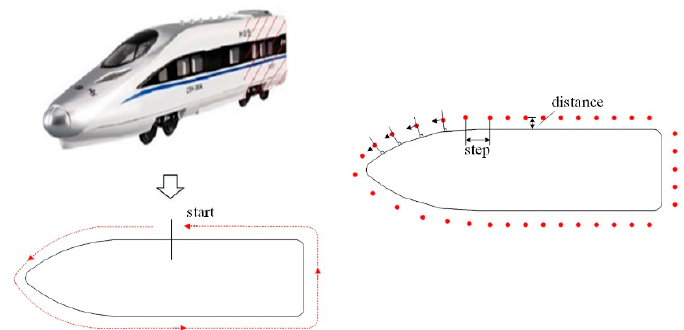
Figure 9. The closed figure obtained by projecting the 3D model onto the 2D plane.